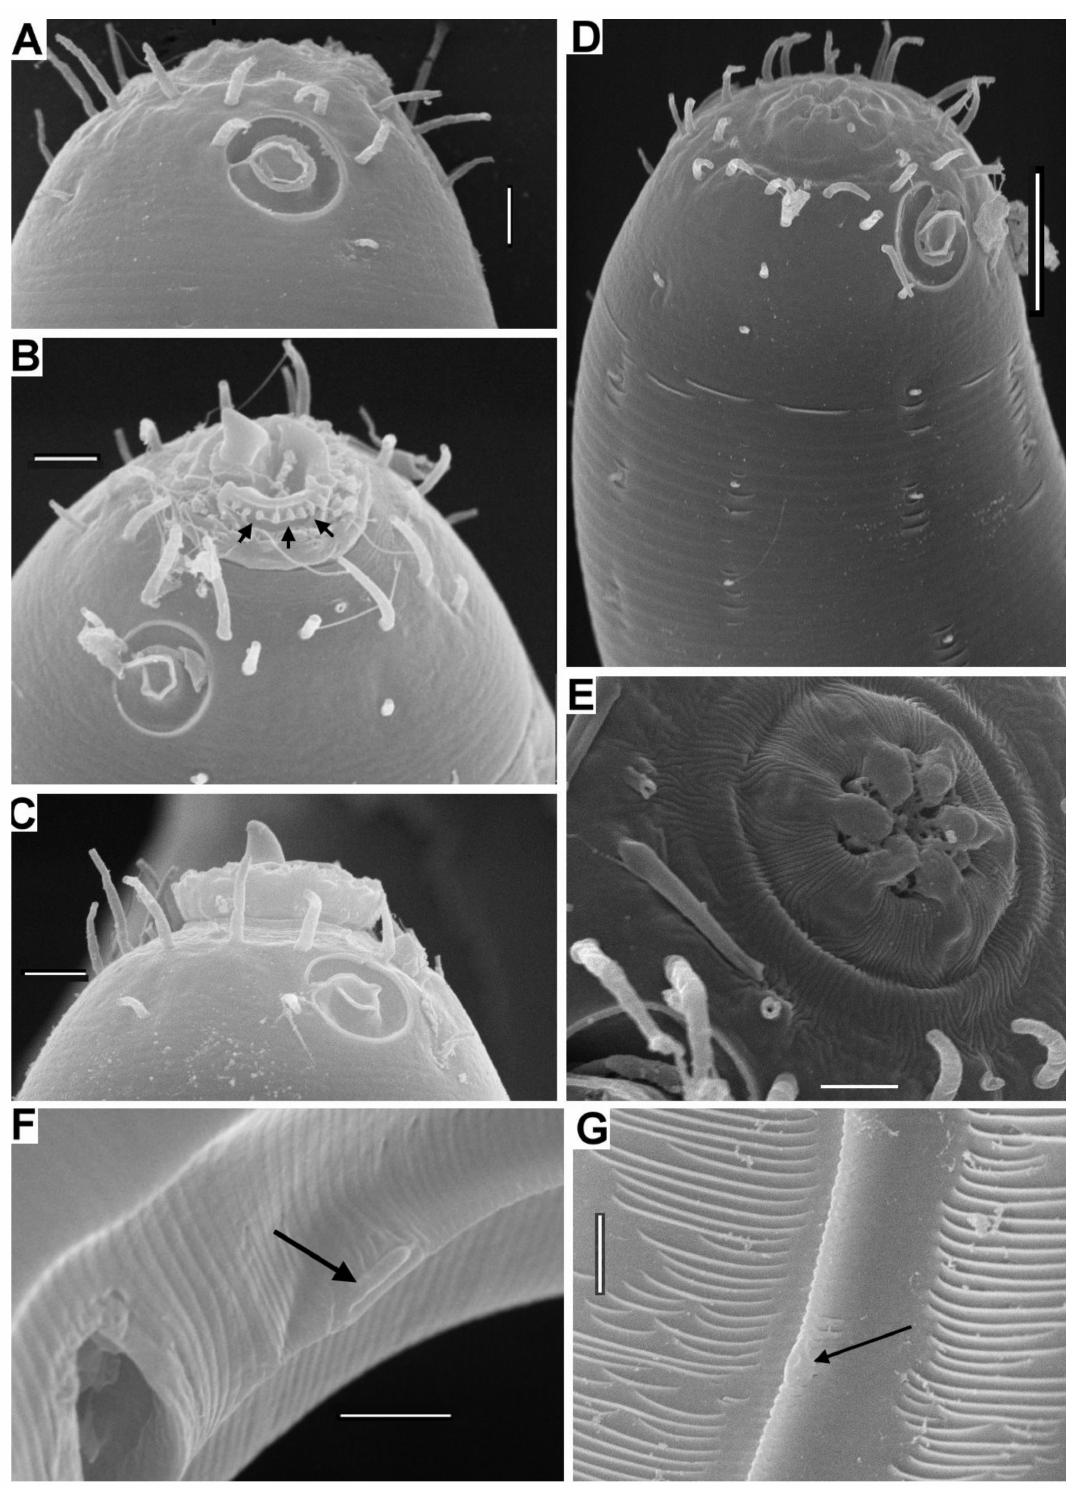
Figure 10. Acanthopharynx micans , SEM-pictures: ( A ) lateral view of the head; ( B ) head, subapi- cal view; dorsal tooth protruded, little arrows indicate protruded lateroventral row of denticles; ( C ) lateral view of the head, labial region, and dorsal tooth protruded; ( D ) anterior end, laterodorsal view; ( E ) labial region; ( F ) cloacal opening and preanal supplementary papilla (arrow); ( G ) pore on the precloacal ridge (arrow). Scale bars: ( A ) 3 µ m, ( B ) 3 µ m, ( C ) 3 µ m, ( D ) 10 µ m, ( E ) 2 µ m, ( F ) 3 µ m, ( G ) 3 µ